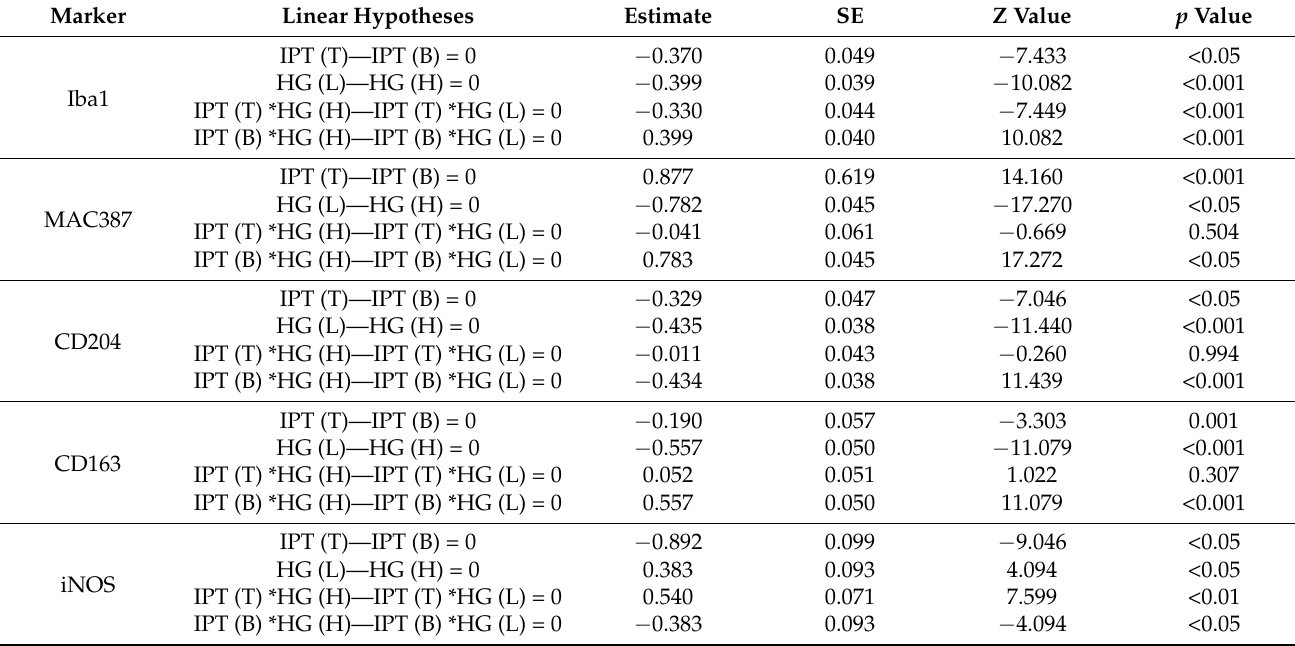
Table 2. Results of the post-hoc Tukey’s Honestly Significant Difference test for all pairwise comparisons in the model classified with ∆ AIC C <2 for the number of macrophages observed with each